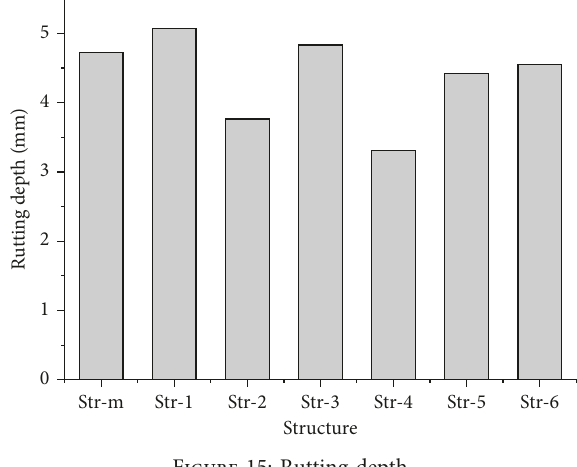
Figure 15: Rutting depth.